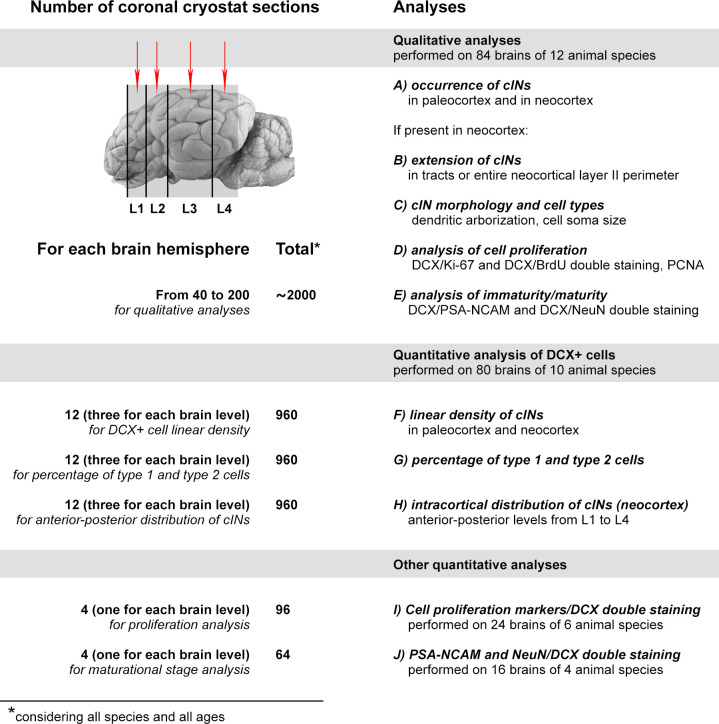
Summary of the qualitative and quantitative analyses performed in this study.